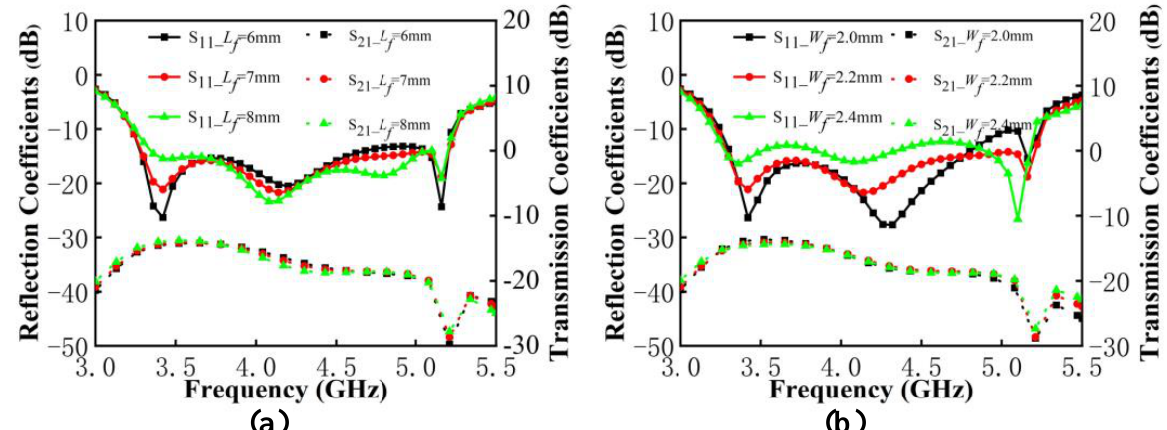
Figure 10. ( a ) S-parameters of proposed antenna pairs with different values of L f . ( b ) S-parameters of proposed antenna pairs with different values of W f .